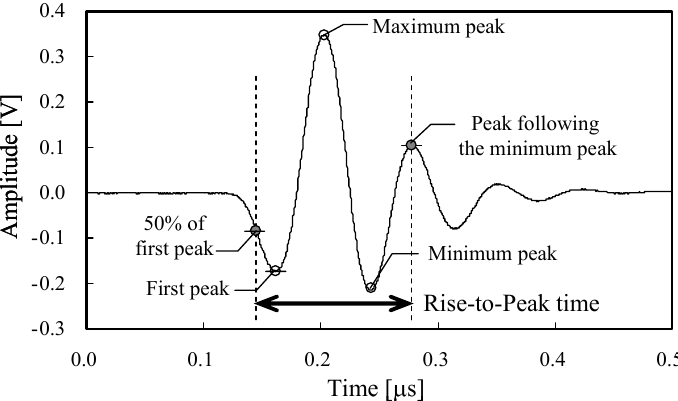
Figure 2: Typical pulse waveform of an ultrasound echo. Center frequency: 10 MHz. Sampling frequency: 1 GHz. The “Rise-to-Peak time” is defined as the time interval between the rise of the first peak (50% amplitude of the first peak) and the first positive peak following the minimum peak of the echo.